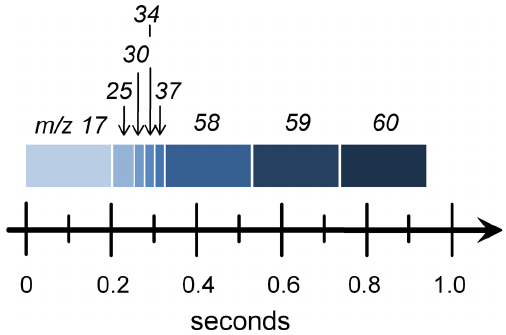
Fig. 3. HT-CIMS measurement cycle with several molecular masses and associated dwell times of 0.2, 0.05 and 0.02s, respec-